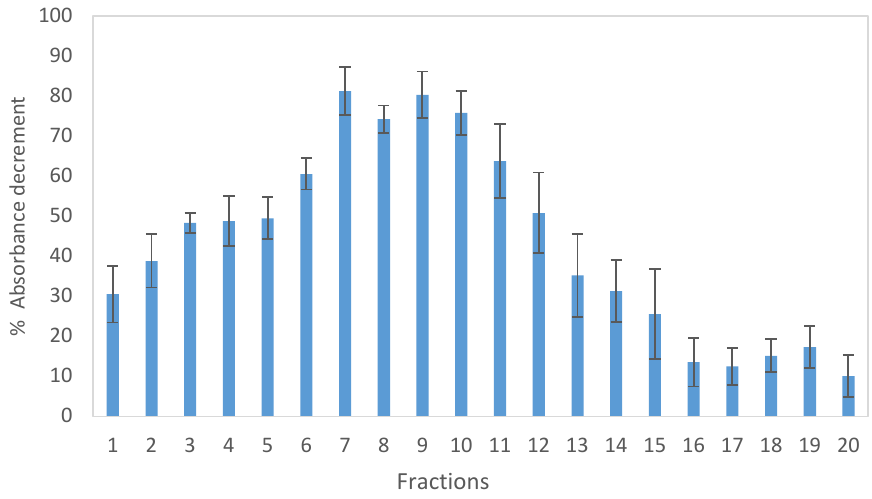
Figure 6. Absorbance decrement (%) after DPPH reaction of methanolic extract fractions.